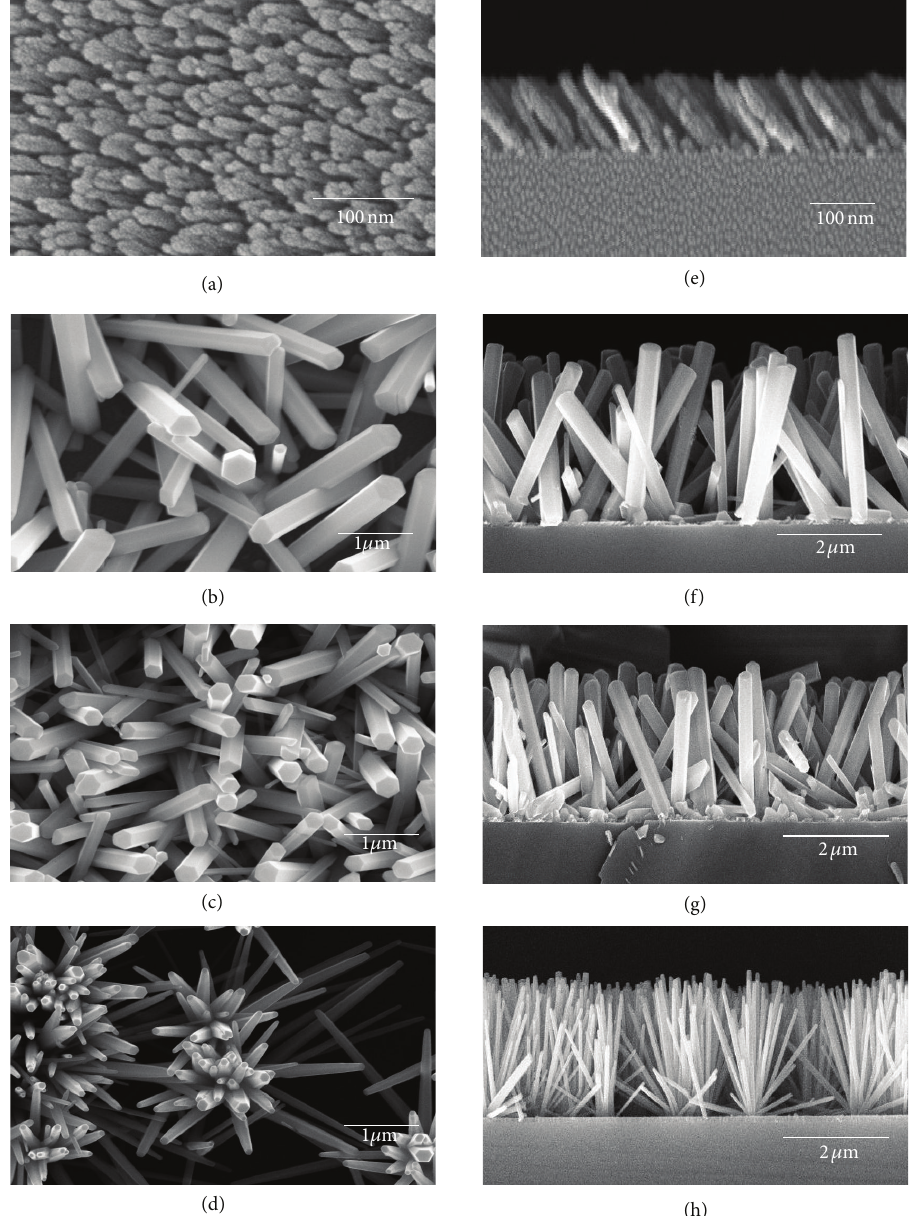
Figure 1: SEM images of the top view of (a) TiO 2 nanorods, (b) ZT-300, (c) ZT-400, and (d) ZT-500 and cross-sectional view of (e) TiO 2 nanorods, (f) ZT-300, (g) ZT-400, and (h)